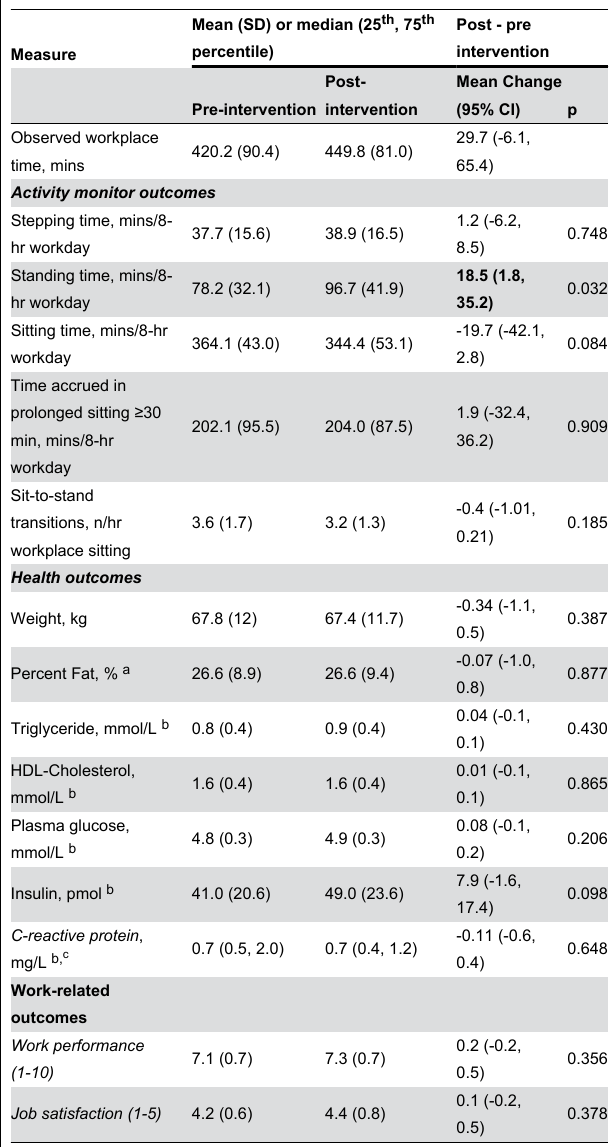
Table 1. Workplace activity, health, and work-related outcomes before and after transitioning to an activity- permissible workplace (Vancouver, Canada, 2011: